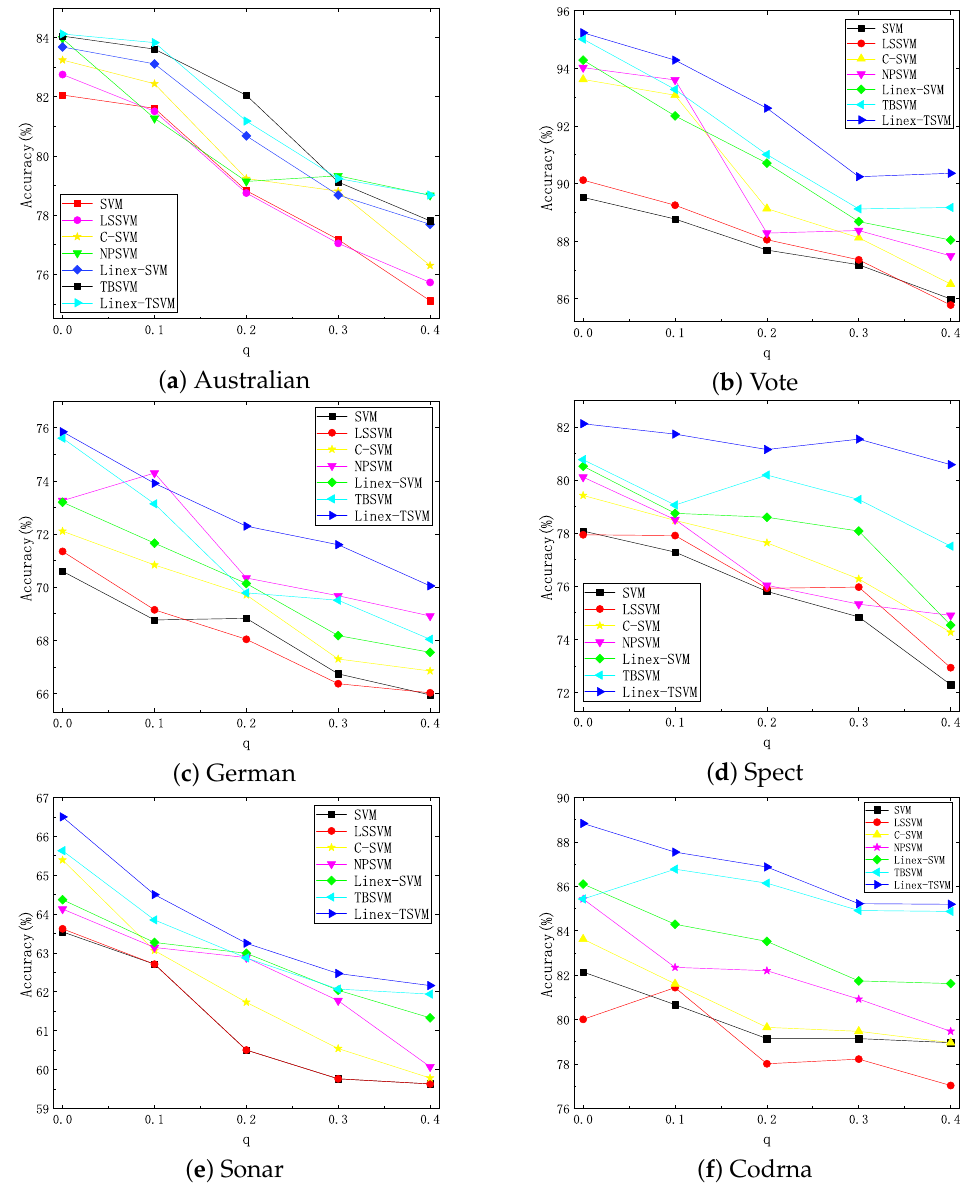
Figure 4. Accuracies of seven algorithms via different noises